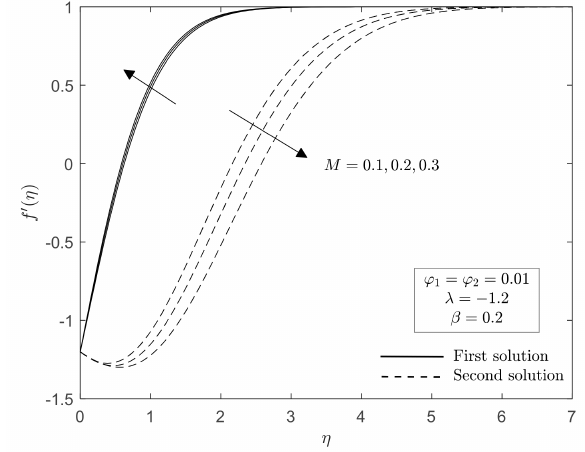
Figure 9. Velocity profile f (cid:48) ( η ) for selected values of magnetic parameter M (Shrinking sheet case) when β = 0.2.